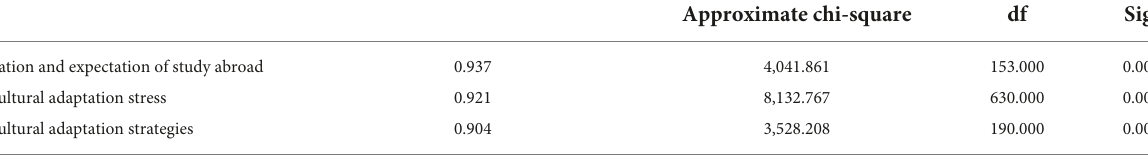
TABLE 2 Scale validity